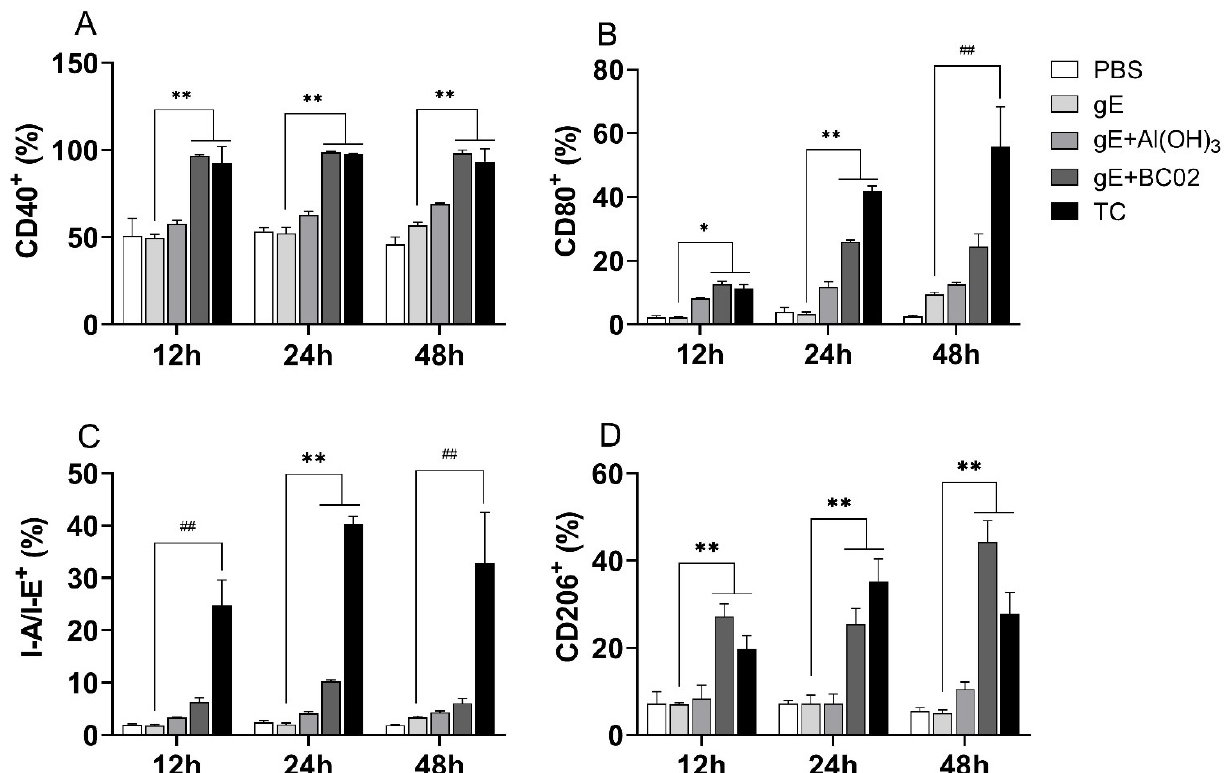
Figure 7. BC02-adjuvanted gE experimental vaccine up-regulates the expression of I-A/I-E and cell-surface costimulatory molecules in murine macrophages. ( A – D ): RAW264.7 cells were stimulated with 1/25 dose of experimental vaccine at different time points (12–48 h). The cells were collected and the abundance of costimulatory molecules CD40, CD80, I-A/I-E and CD206 on the cell surface was detected by flow cytometry. *, ** and ## indicates that there is a significant statistical difference between 1/25 dose of TC and gE + BC02 MD compared with the gE group, or 1/25 dose of TC compared with gE group, respectively, p < 0.05.